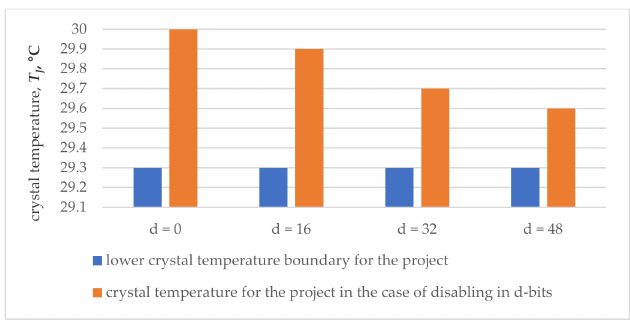
Figure 2. Results of thermal monitoring for 32 bit